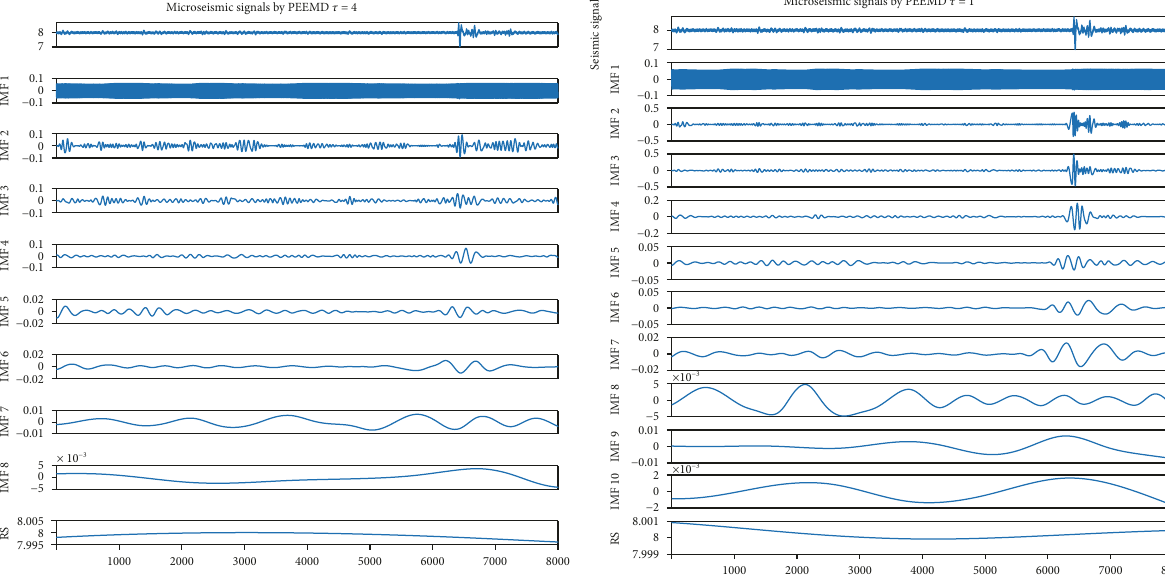
Figure 7: The decomposition of microseismic signals via the PEEMD method with τ = 4, 1